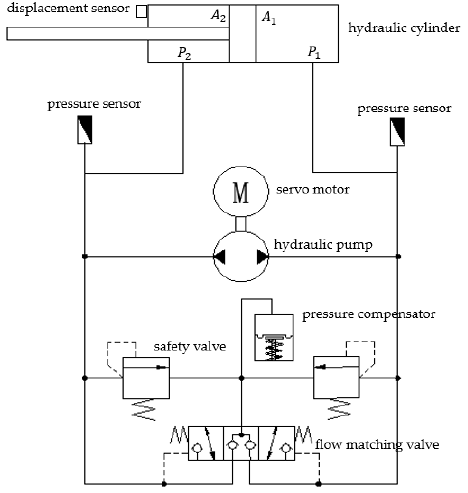
Figure 1. EHA hydraulic principle schematic.